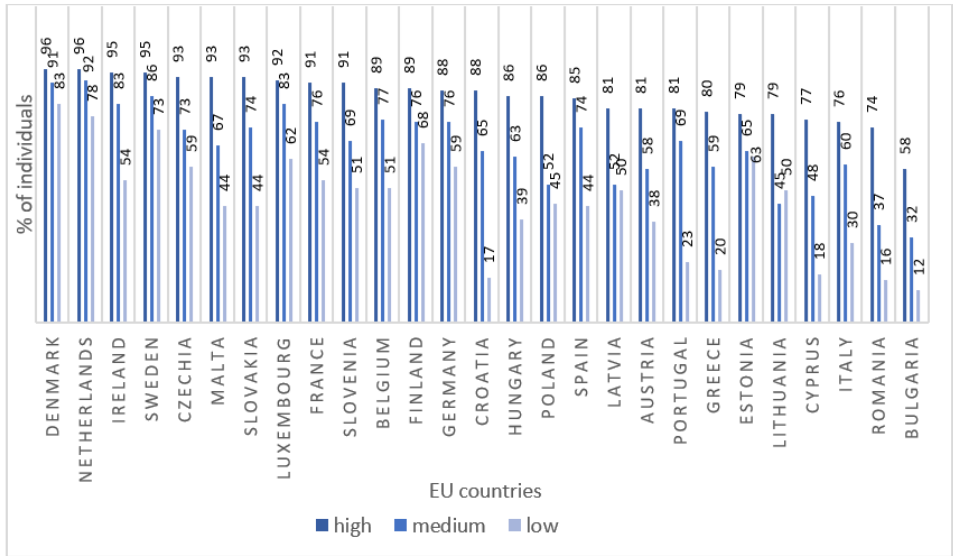
Figure 1. Internet purchases by individuals in EU countries by education level in 2021, % of individuals. (Source: Data retrieved from Eurostat database, accessed on April 2022); ISCED 2011- Classification for educational level.